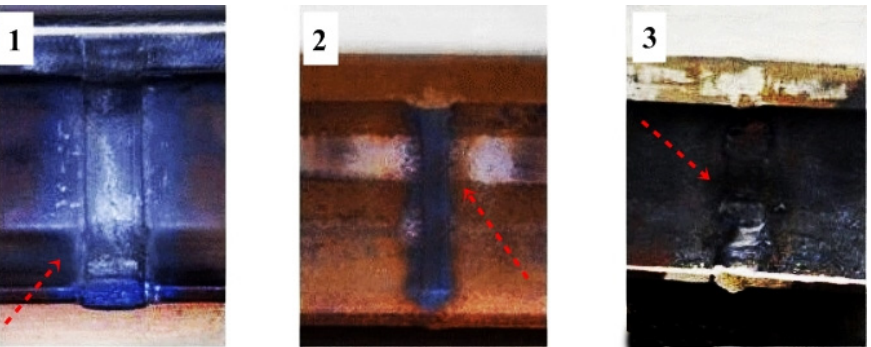
Figure 1. Basic methods of connecting rails, ( 1 ) thermite welding, ( 2 ) electric spark welding, ( 3 ) arc welding.